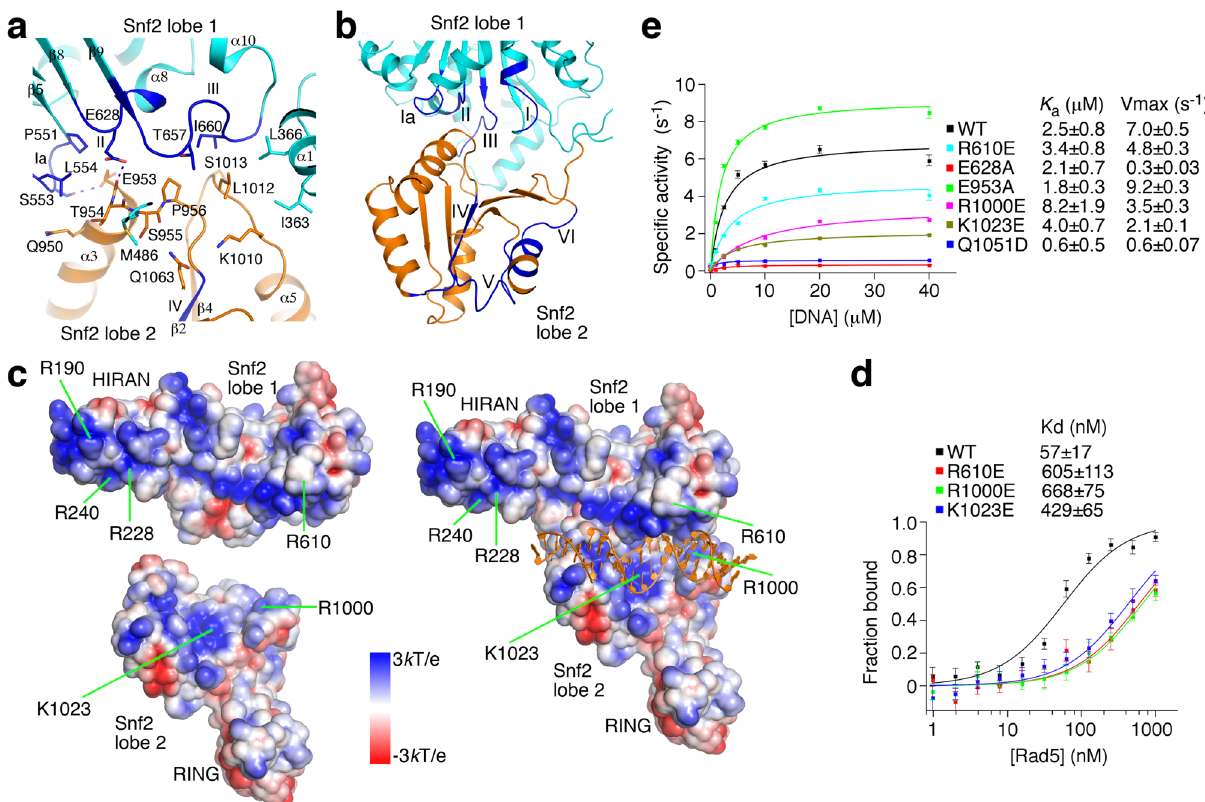
Fig. 2 Kl Rad5 ’ s Snf2 domain rests in an ATPase-inactive conformation and is activated by dsDNA. a The interface between the Snf2 domain lobes 1 and 2 observed in our structure. Residues important for the lobes 1 – 2 interaction are highlighted. Dashed lines indicate hydrogen bonds. b Locations of the conserved motifs in the Snf2 domain in our structure (blue). c Electrostatic potential on the Kl Rad5 protein surface. In the left panel, the N- and C-terminal halves of Kl Rad5 are shown separately. The N-terminal half contains the HIRAN domain, the mediator helix, and the Snf2 domain lobe 1; the C-terminal half contains the Snf2 domain lobe 2 and the RING domain. In the right panel, Kl Rad5 is modeled in the dsDNA (orange)-bound conformation based on the Snf2-nucleosome complex structure 22 . Its N- and C-terminal halves are treated as rigid bodies in the model. d FP experiments probing dsDNA binding to the wild-type (WT) and substituted Kl Rad5. e dsDNA-stimulated ATPase activity of the wild-type and substituted Kl Rad5. Data in panels d and e are presented as mean values + / − standard deviations of three independent experiments. Errors in K d , K a , and V max are derived from data- fi tting. Source data for panels d and e are provided as Source Data fi